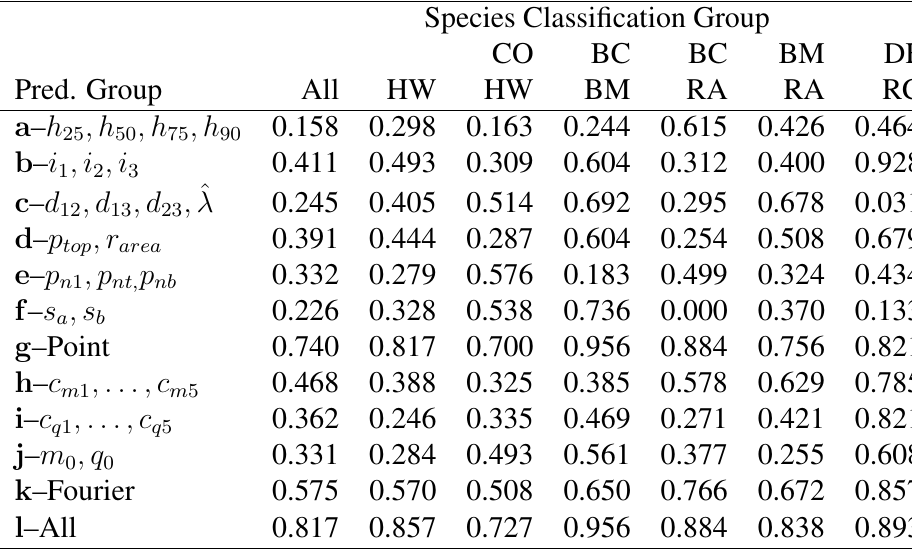
Table 6. Kappa statistics of the support vector machine applied with a five-fold cross validation to different predictor variable groups and species